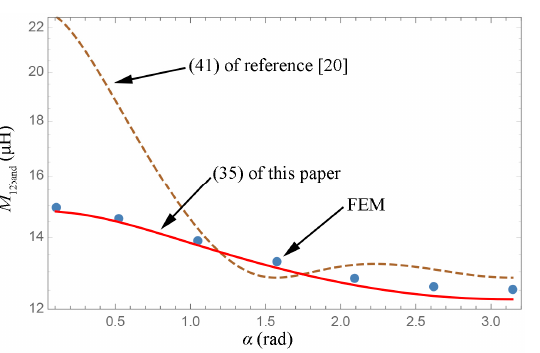
Figure 13. Tape-width ( α ) dependence of the mutual inductance ( M 12band